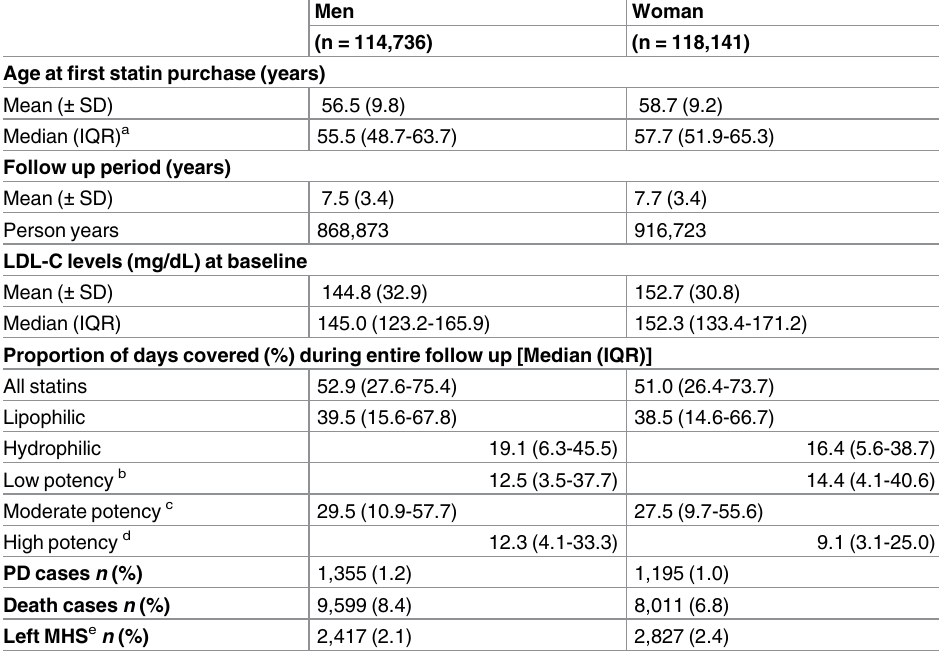
Table 1. Characteristics of the statin- users cohort (n = 232,877);by sex. Men Woman (n = 114,736) (n =